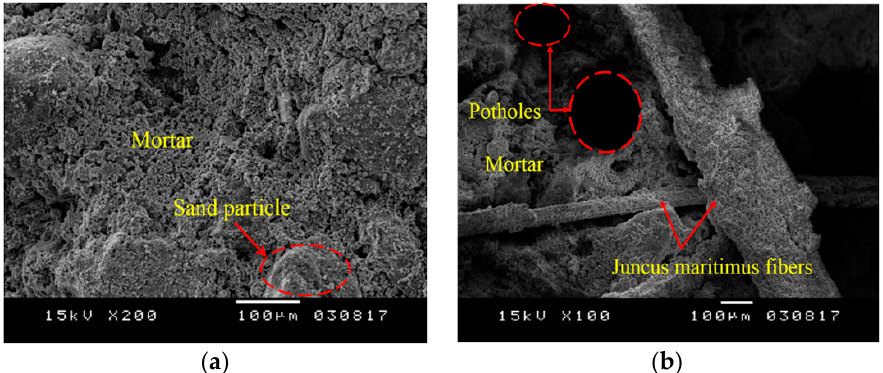
Figure 4. Scanning electron microscopy images: ( a ) Reference mortar (without fibers); ( b ) Juncus maritimus/mortar composites.